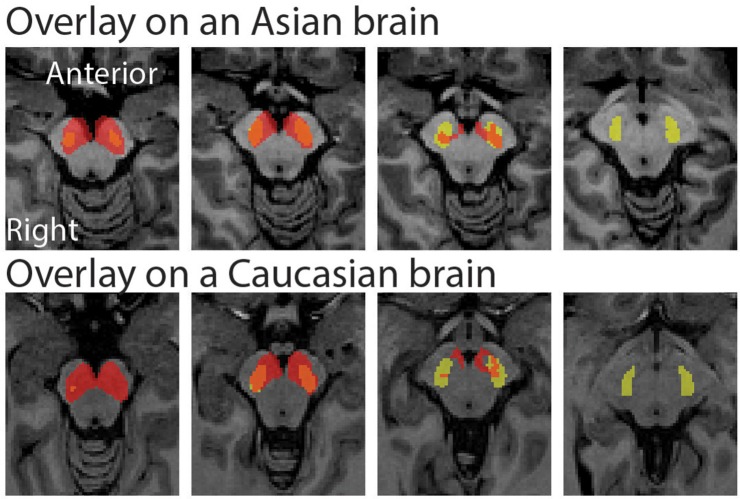
Morphological differences between Asian and published SN templates. Asian (red) and published (yellow) templates of SN transferred to an individual space were overlay on an Asian sample from dataset 2 (the upper raw), and that of SN templates were overlay on a Caucasian template (the bottom row).